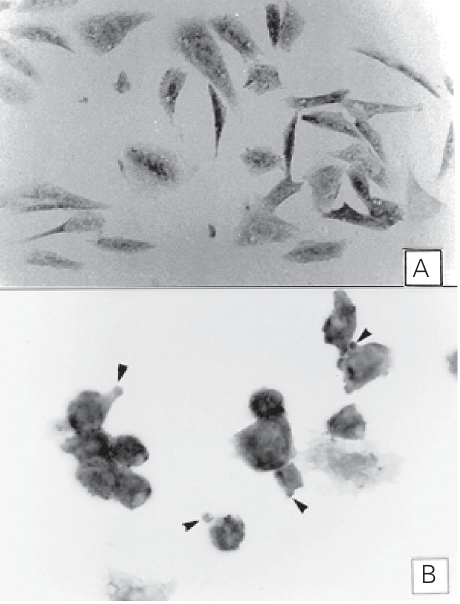
Figure 4. Morphological changes induced by purified Serratia mar- cescens cytotoxin (2 CD 50 dose) in CHO cells stained with toluidin blue (100X). A , Typical morphol- ogy of the control cells; B , cyto- plasmic retraction, nuclear com- pactation and cytoplasmic bleb- bing (arrowheads) after 30 min of treatment.